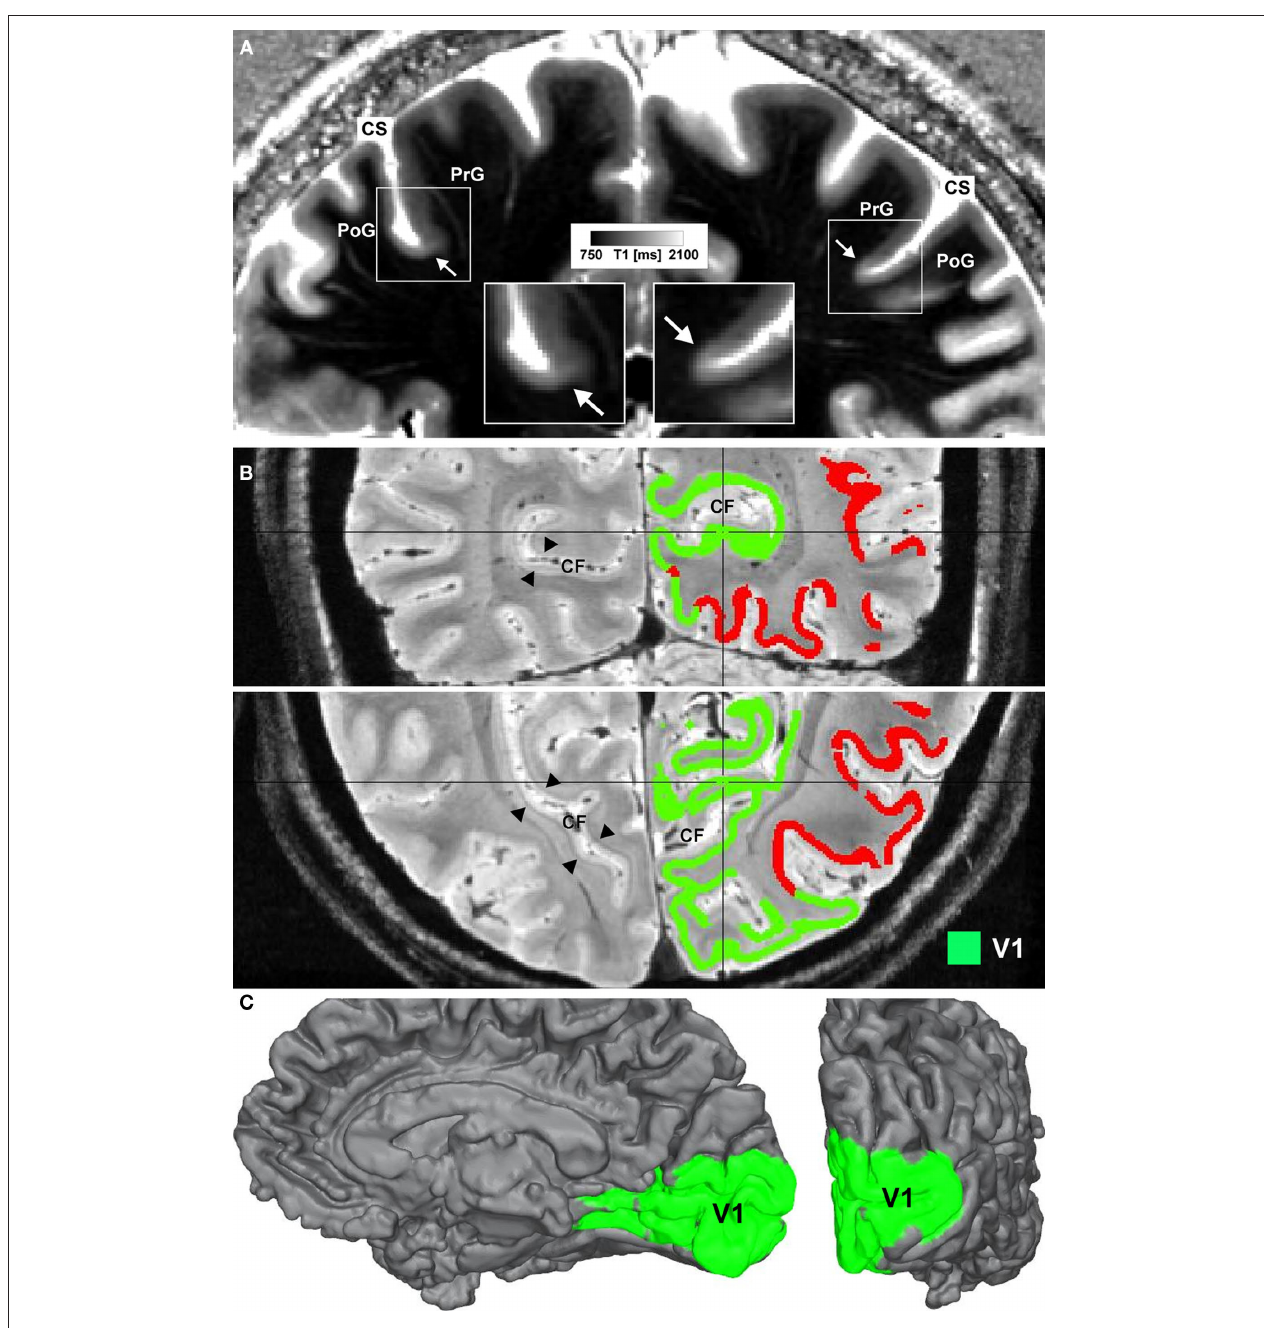
Cortical surfaces were reconstructed on the basis of a high-resolution T1-weighted image (not shown) using a level-set approach. Additional transcortical profiles were computed perpendicular to the isosurfaces of the level-set function. Sampling the FLASH data along these profiles extracts laminar fingerprints for each point on the cortical surface that can be interpreted as feature vectors in a multi-dimensional space. Feeding those into an automatic k-means clustering algorithm parcellates the cortex into areas of similar laminar structure. The green cluster indicates the area containing the Stria of Gennari and marks the primary visual cortex (V1). CF = calcarine fissure. (C) The same cluster as in (B) is mapped onto an intermediate ( ∼ 1.5 mm from gray/white matter border) cortical surface. The medial surface (left) and the occipital pole (right) are